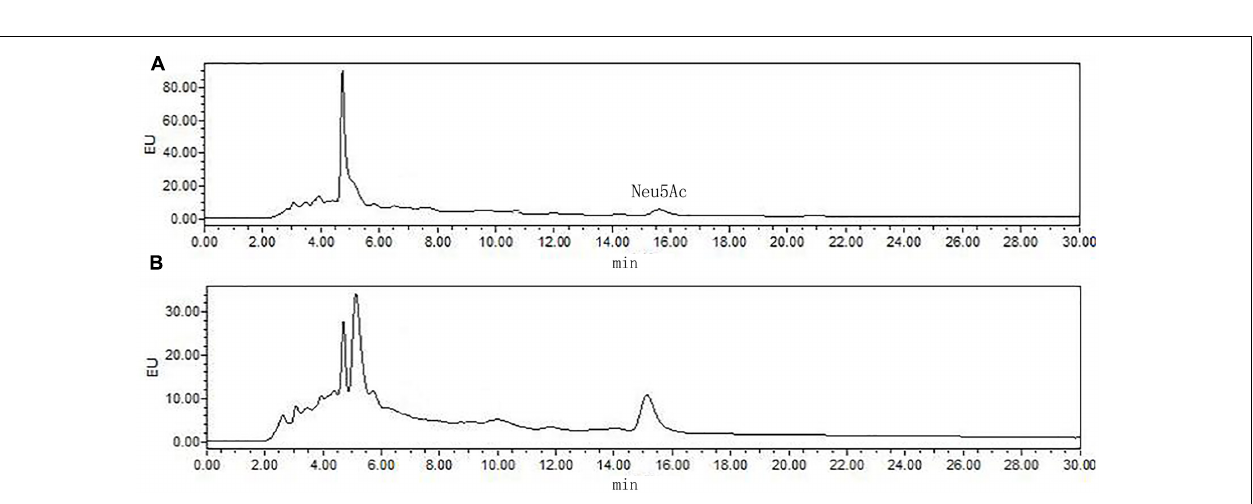
FIGURE 8 | High performance liquid chromatography chromatograms of sialic acid (Neu5Ac) in control (A) and rutin (B) groups.